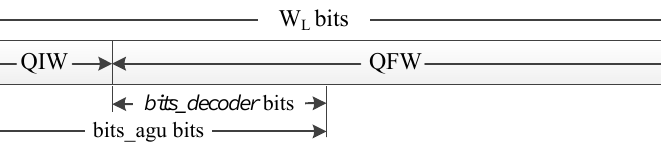
Figure 5. Input data structure, x.